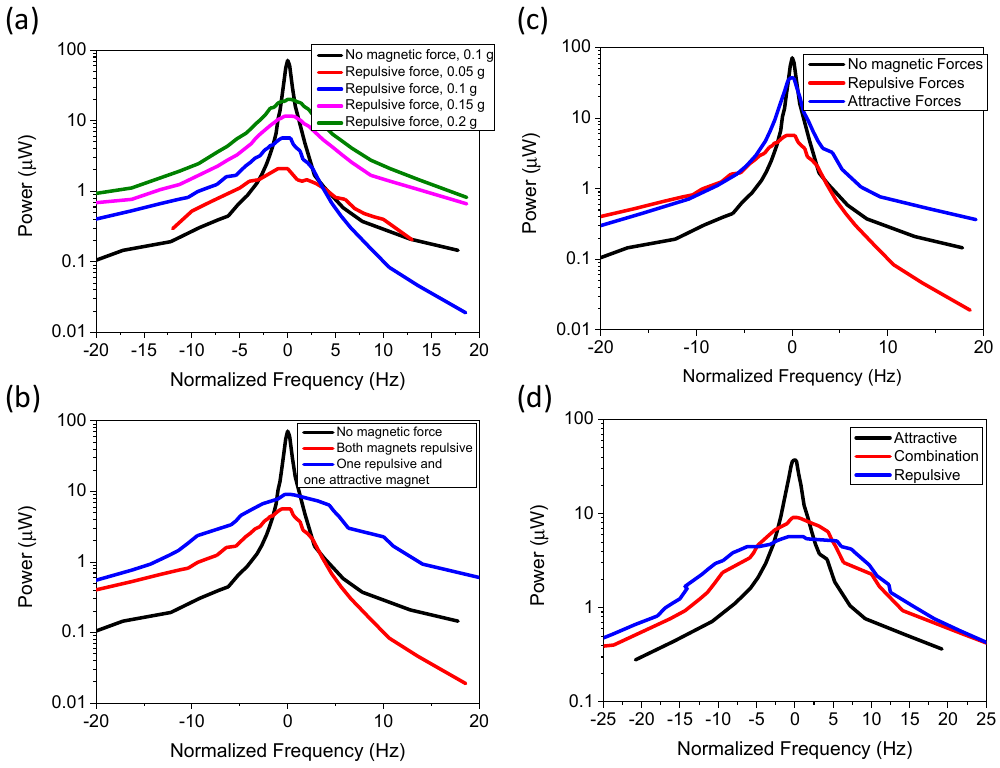
Figure 10. Experimental results for out-of-plane configuration: ( a ) for both repulsive forces with varying acceleration; ( b ) comparing repulsive forces with attractive and repulsive forces at 0.1 g; ( c ) comparing attractive forces and repulsive forces; ( d ) combining repulsive and attractive forces at 0.1 g.